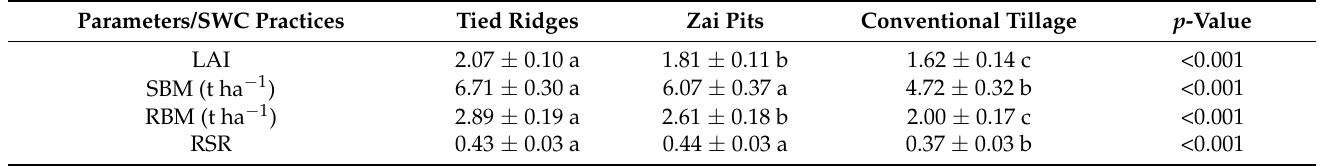
Table 3. Variation in maize growth parameters under selected SWC practices in the Ruzizi Plain. Parameters/SWC Practices